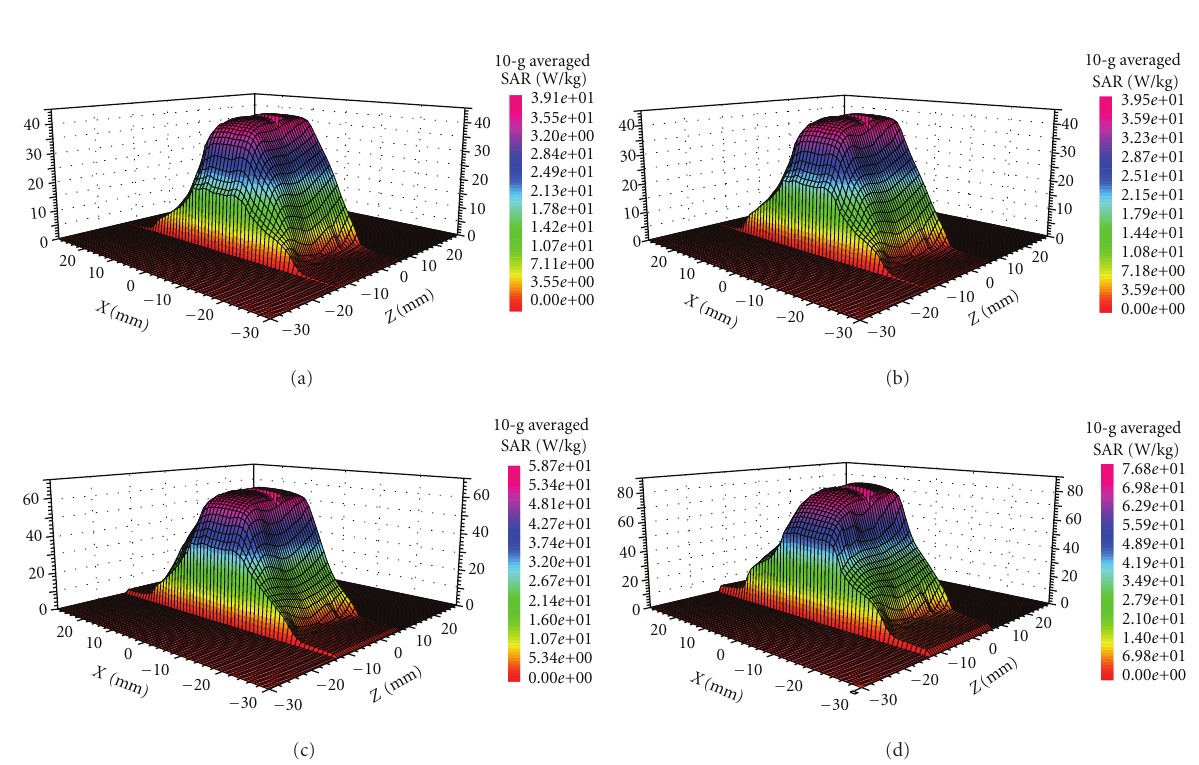
Figure 13: Simulated 10g averaged SAR distribution (delivered power = 1 W, SAR calibration line was placed at Y = 0mm), (a) 401MHz, (b) 433 MHz, (c) 1.427 GHz, and (d) 2.4